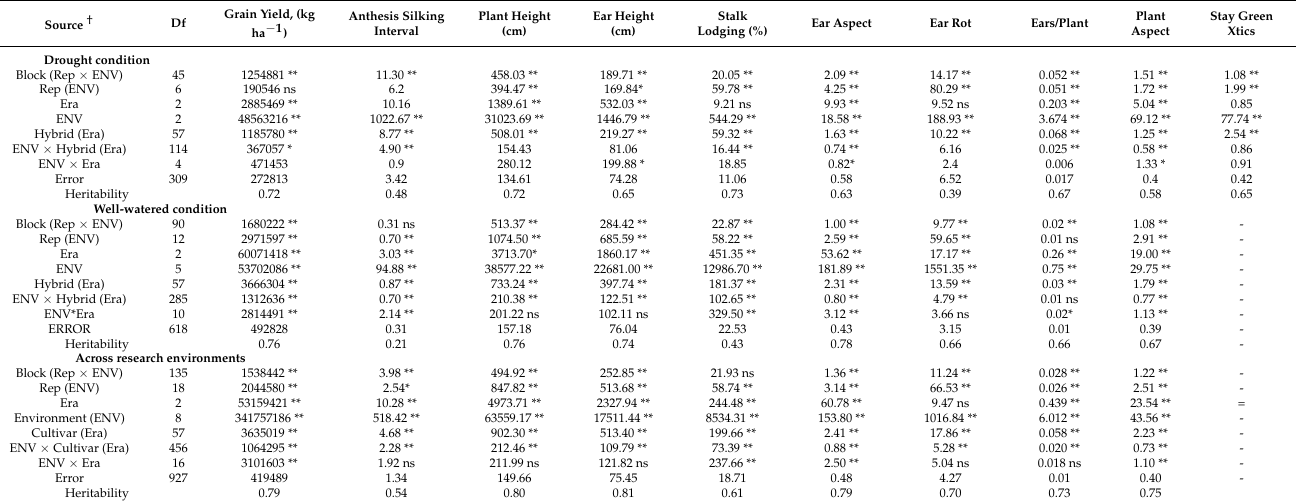
Table 2. Mean squares for grain yield and other agronomic traits of extra-early maize hybrids evaluated under drought, well-watered, and across research conditions in Nigeria between 2016 and